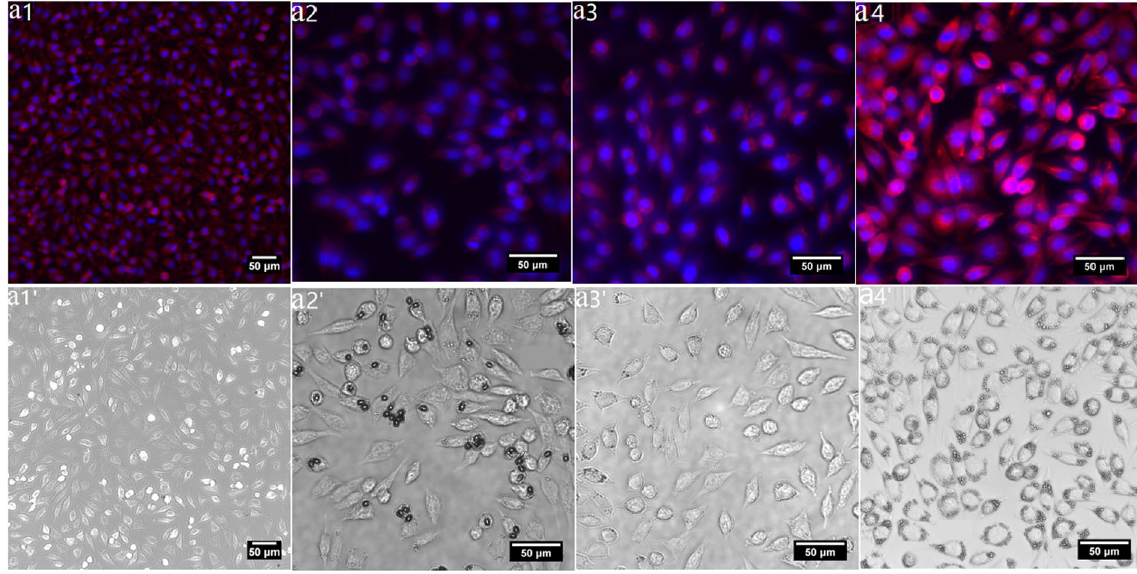
Figure 6. Biocompatibility assay using L929 cell. ( a1 – a4 ) Merged fluorescent images of L929 cell morphology treated by C-C/GLSP/C- U /C- T (1 mg/mL); ( a1 ′ – a4 ′ ) bright-field fluorescent image of ( b1 – b4 ) respectively.